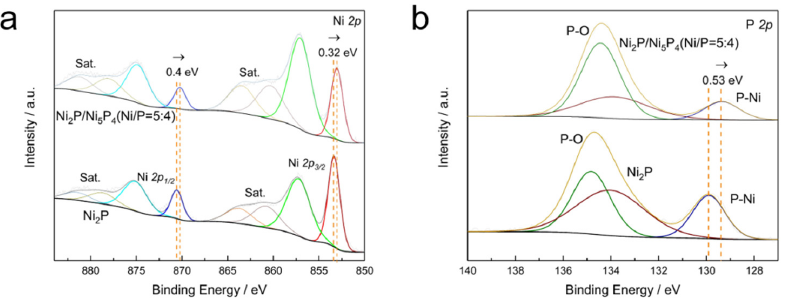
Figure 5. The XPS test and analysis of single-phase Ni 2 P and Ni 2 P/Ni 5 P 4 (Ni/P = 5:4). ( a ) The XPS spectrum of single-phase Ni 2 P and Ni 2 P/Ni 5 P 4 (Ni/P = 5:4) on the Ni 2p orbital. ( b ) The XPS spectra of single-phase Ni 2 P and Ni 2 P/Ni 5 P 4 (Ni/P = 5:4) on the P 2p orbital.